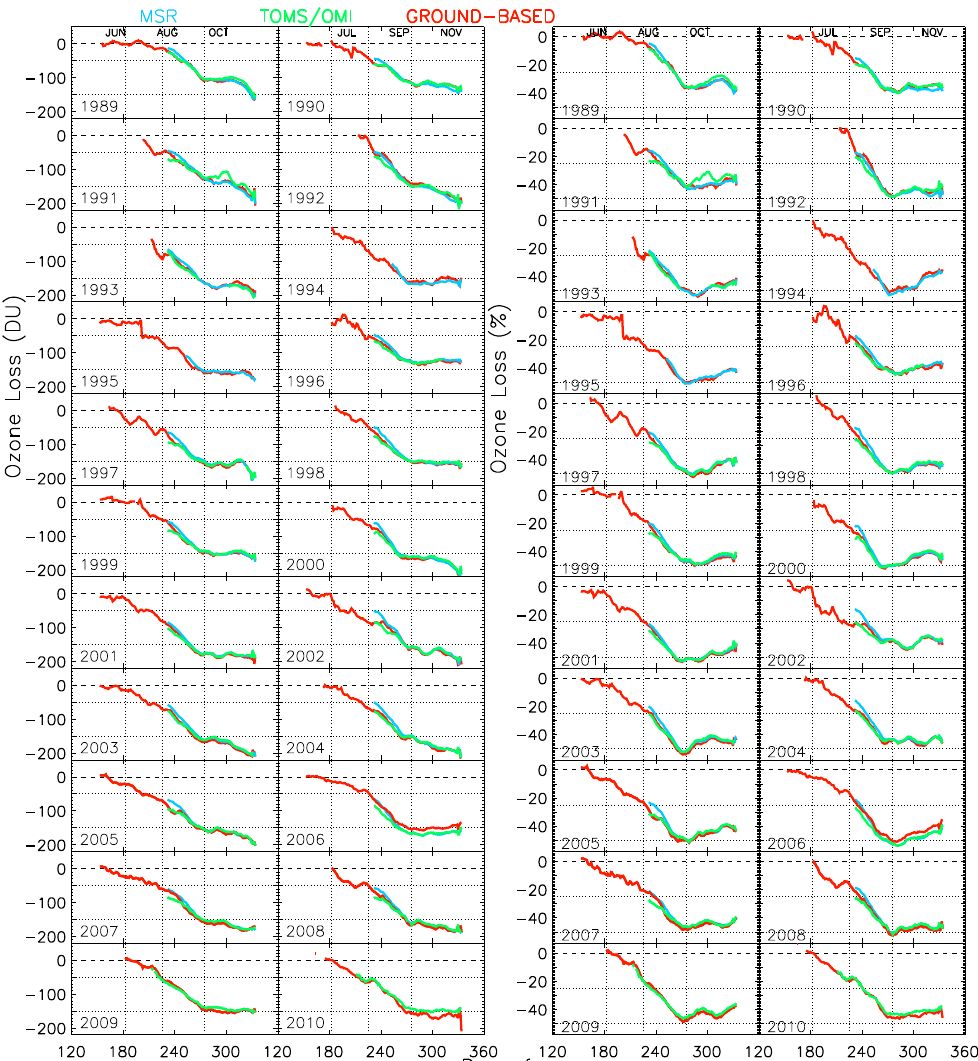
Fig. 3. Temporal evolution of the chemical O 3 loss estimated from ground-based observations (red) inside the vortex is compared to that from TOMS/OMI (green) and MSR (blue) in DU (left panel) and in % (right panel) in 1989–2010. The horizontal dotted lines represent − 50 and − 150DU of O 3 loss (left panel) and − 25 and − 50% of O 3 loss (right panel), while the vertical lines represent day 181, 225 and 275.